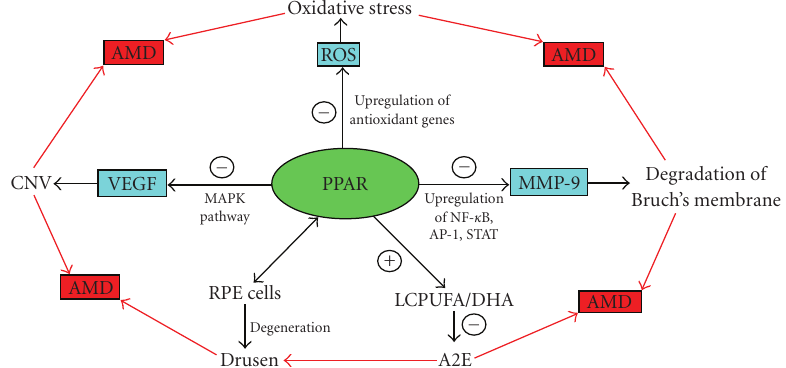
Figure 2: Schematic graph showing PPAR interactions with VEGF, ROS, MMP-9, LCPUFA, DHA, and RPE cells and their role in the development of